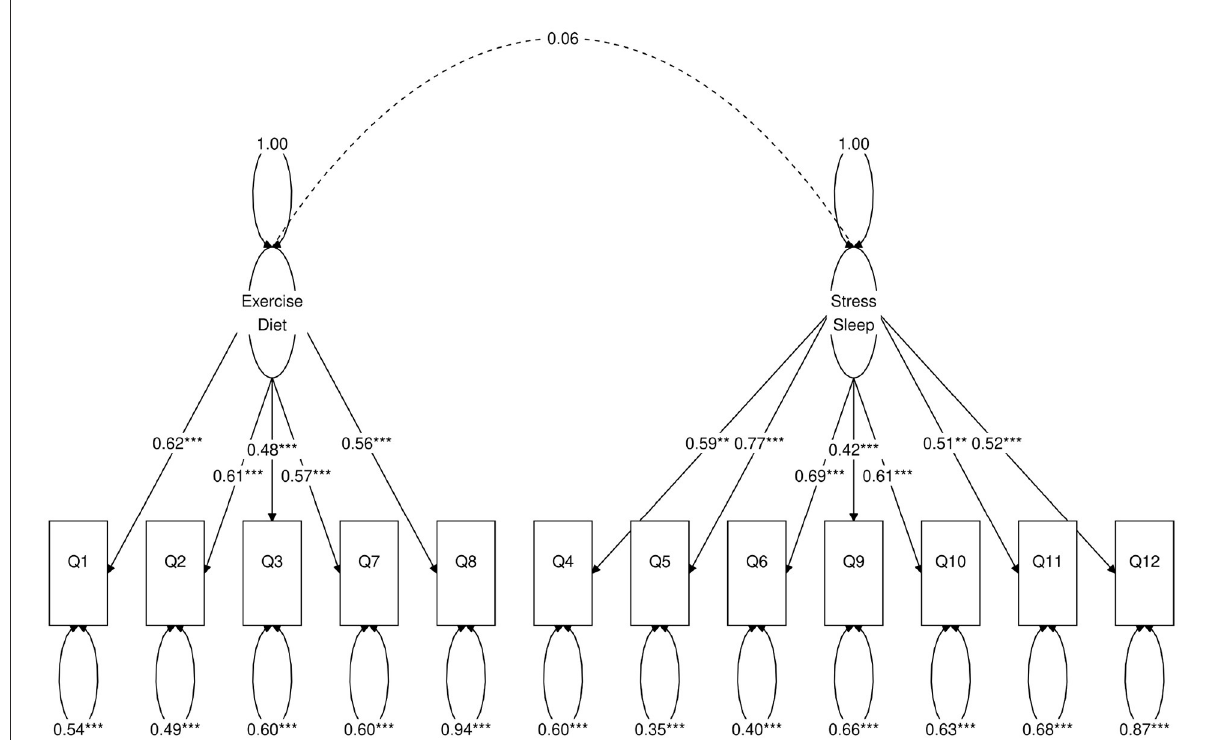
FIGURE2 Path diagram of the two-factor CFA model. *Besides a value means statistical significance. 1-star denotes p < 0.05, 2-star denotes p < 0.01, 3-star denotes p <